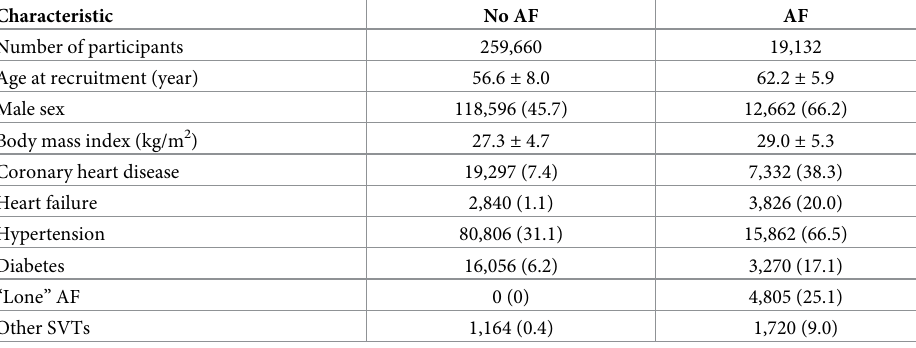
Table 1. Baseline characteristics of participants with AF in UK